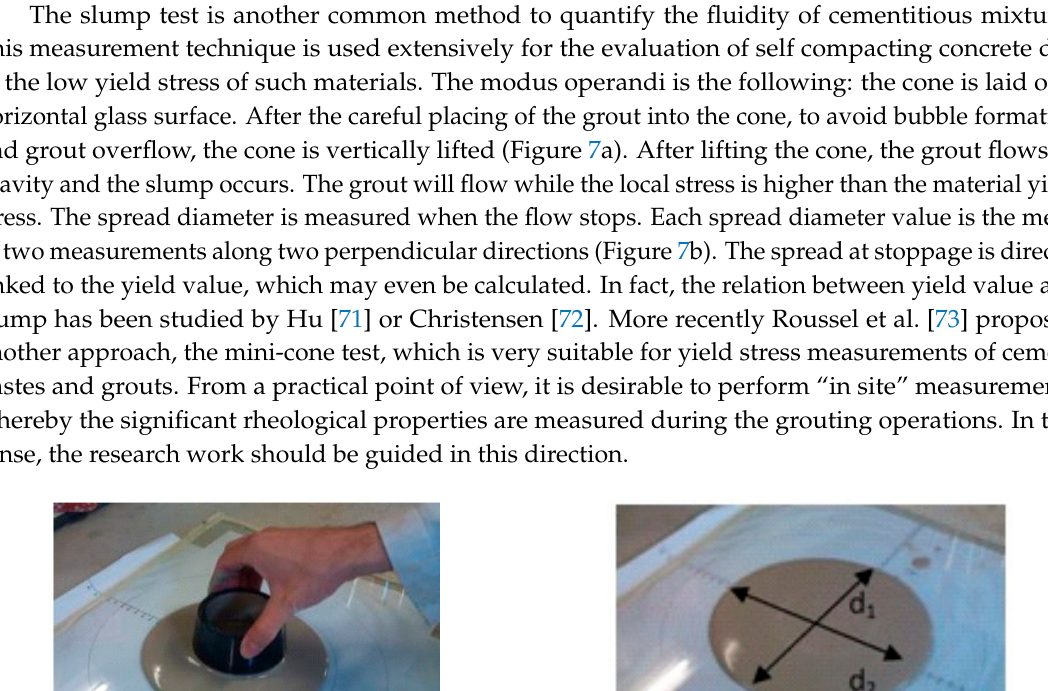
Figure 6. Illustration of the Marsh cone apparatus.